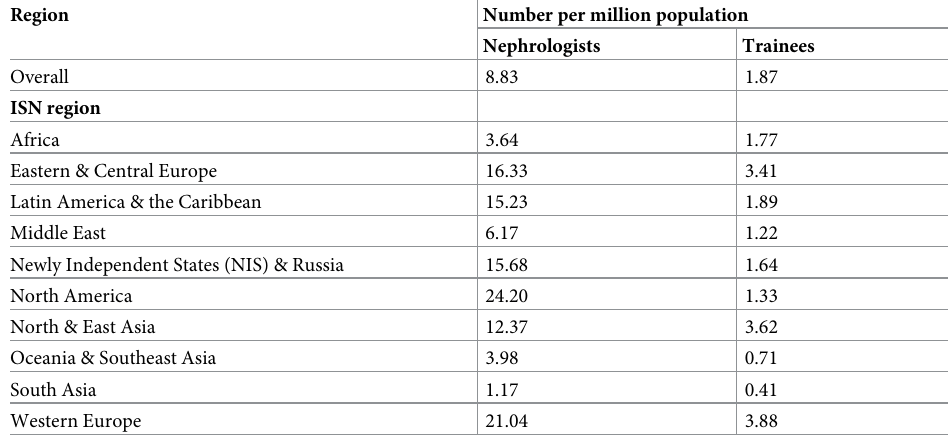
Table 1. Median density of nephrologists and nephrology trainees in International Society of Nephrology (ISN)